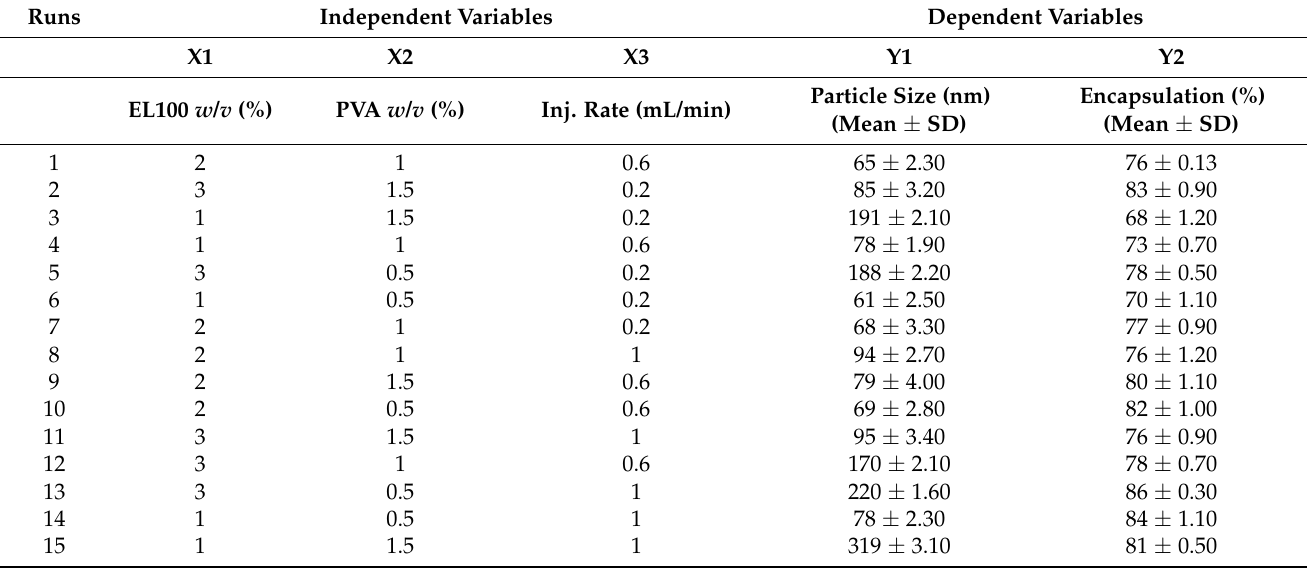
Table 2. Particle size and entrapment efficiency of 15 runs designed by the software.